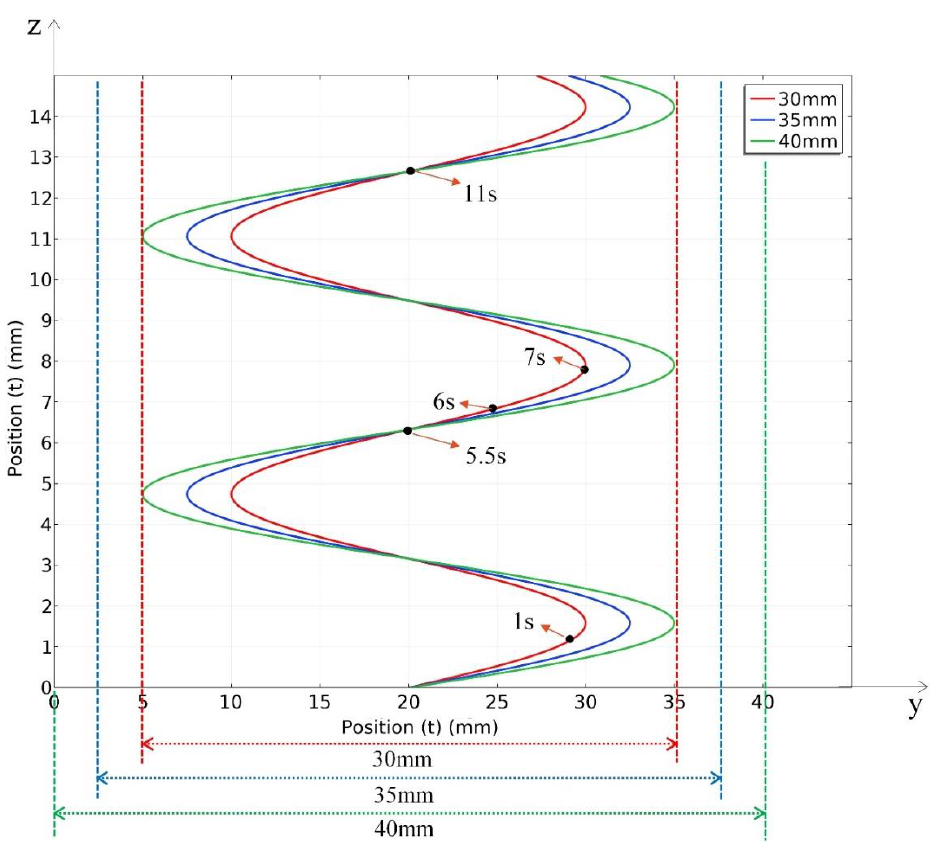
Figure 7. Sinusoidal heat source movement vs. time (t) for 30 mm, 35 mm and 40 mm thick steel plates.